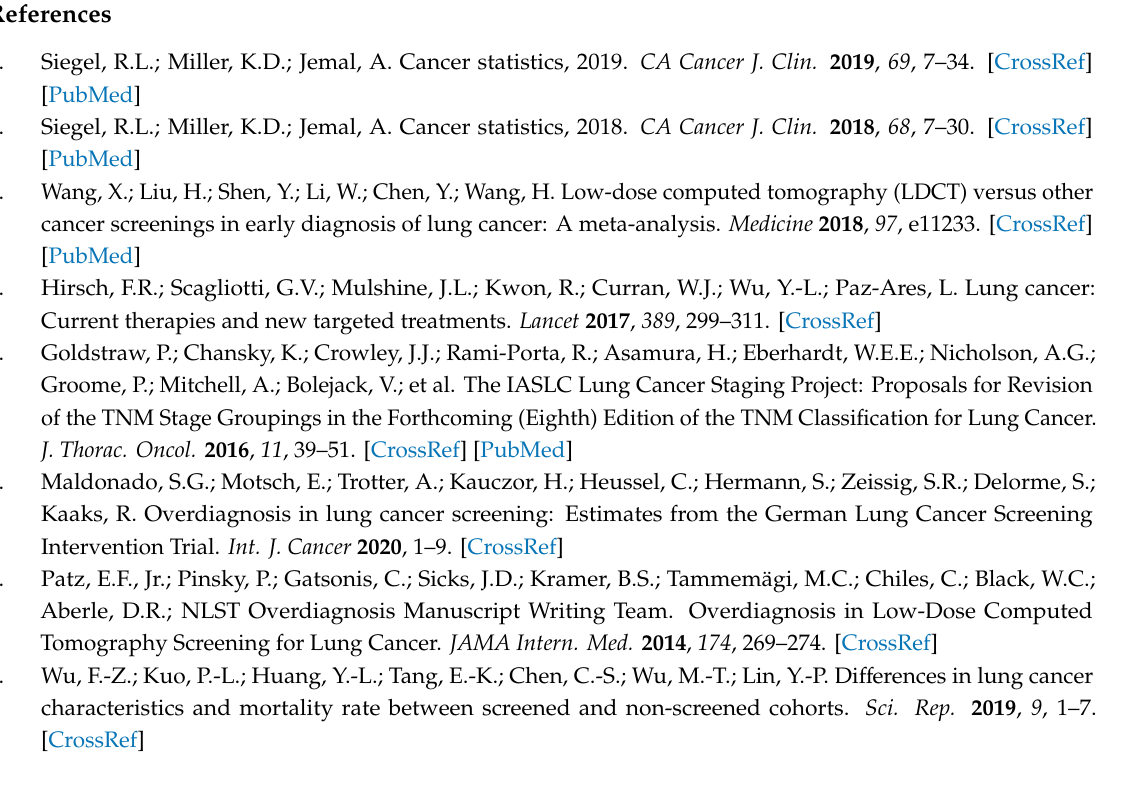
Table S1: Types and subtypes specific distribution of levels of biomarkers in lung cancer samples ( n =